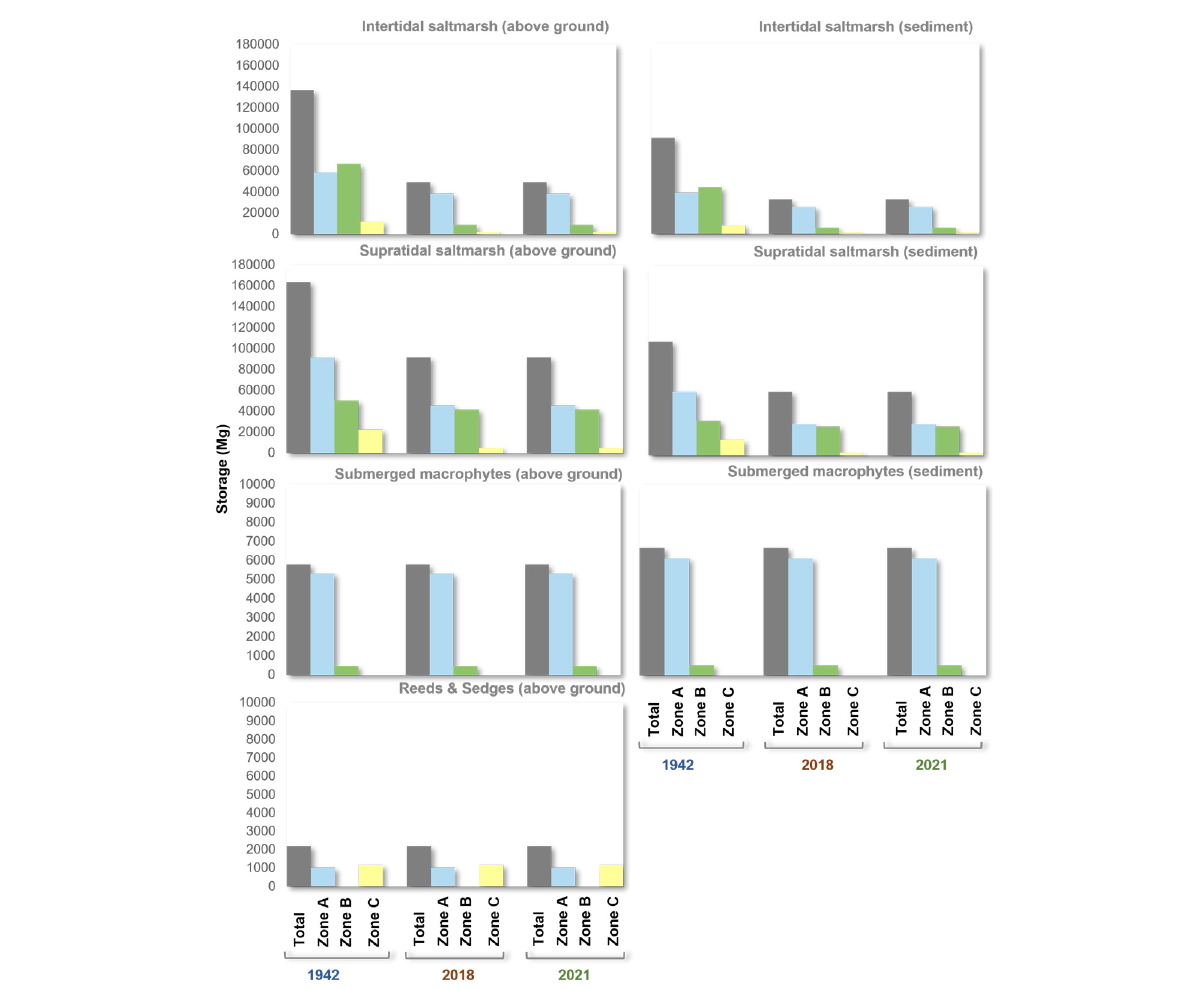
Figure 4: Change in carbon sequestration potential (aboveground biomass and in below ground sediment) across Zones A, B and C in in the Swartkops Estuary between 1942, 2018 and